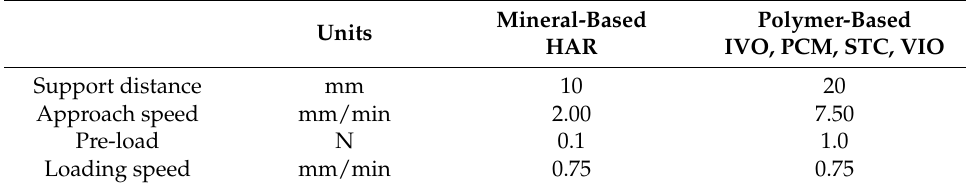
Table 3. Settings employed for the mechanical